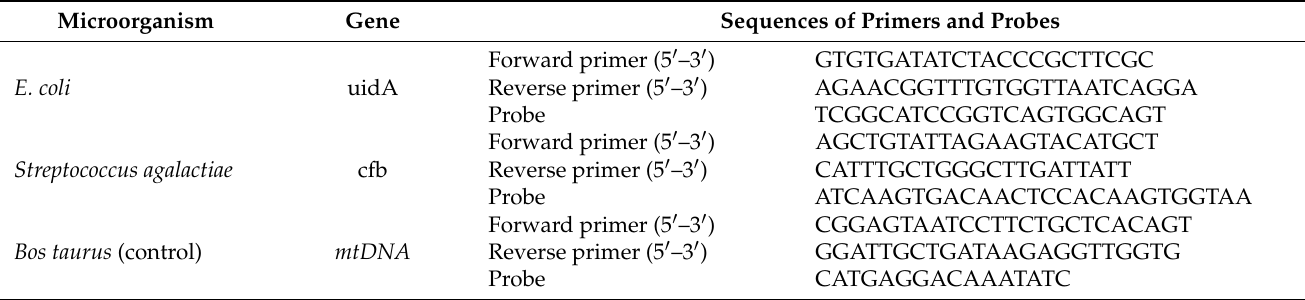
Table 3. Primers and probes for quantitative real time